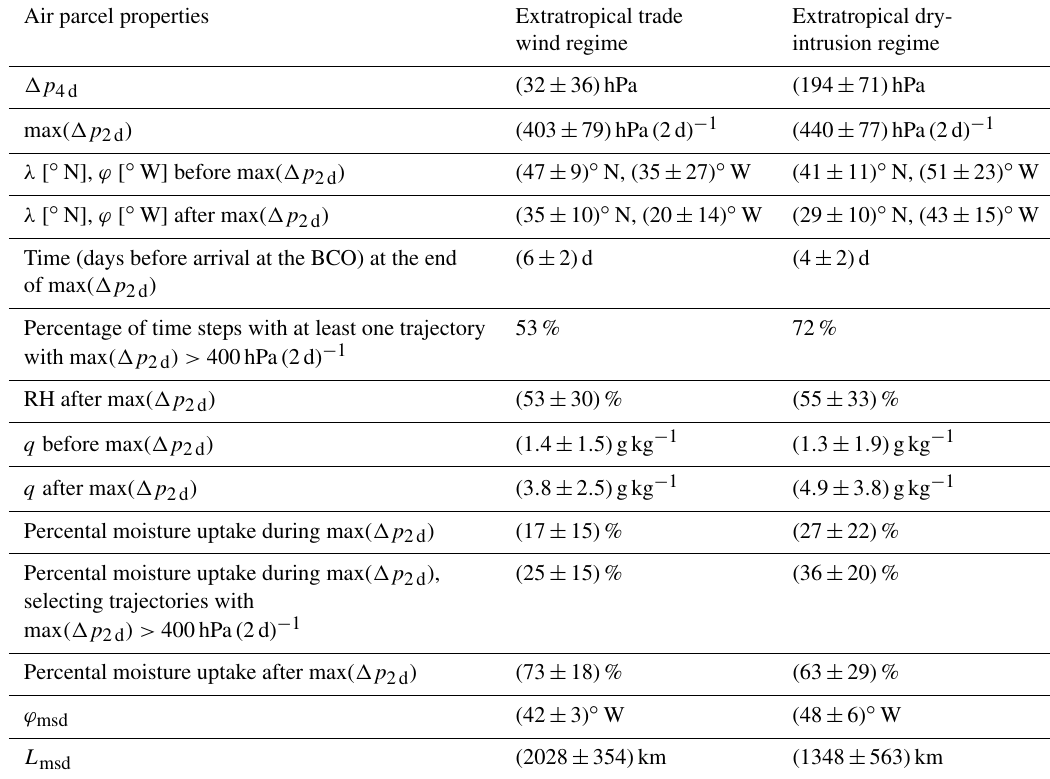
Table 2. Lagrangian characteristics of back trajectories from the BCO classified in either the extratropical trade wind or dry intrusion regime. See text for details. (cid:49)p 4d = p(t BCO ) − p(t BCO − 4d) is the slantwise subsidence rate; max( (cid:49)p 2d ) stands for the maximum subsidence within a 2d period along each of the 10d back trajectories (see Sect. 2.1 and Appendix A). λ is the latitude, ϕ the longitude, RH the relative humidity, q the specific humidity, ϕ msd the weighted mean of the longitude of the source region and L msd the distance to the centre of mass of the moisture source region. Mean conditions ( ± their standard deviations) for the isoTrades period are indicated in the table based on all the trajectories arriving in the sub-cloud layer at the BCO for the two